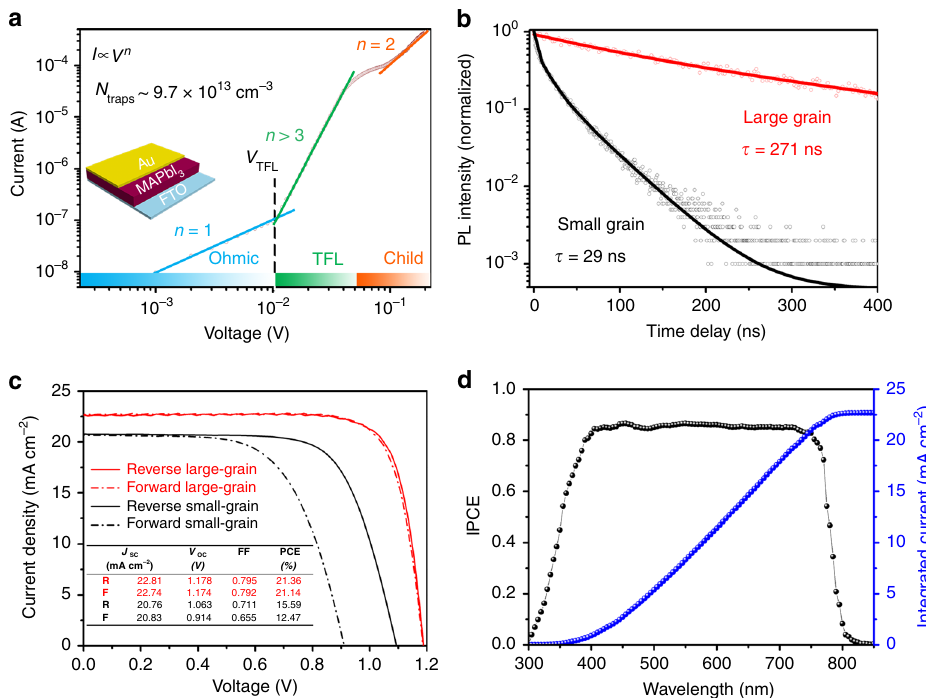
Fig. 4 Characterization of the large-grain MAPbI 3 perovskite fi lms. a Current – voltage ( I – V ) trace of the large-grain MAPbI 3 fi lm, showing Ohmic, TFL, and Child region. The onset voltage of the TFL region is ~0.011 V. b Time-resolved photoluminescence (TRPL) decay measurements of the large- and small- grain MAPbI 3 fi lms. c Characteristic I – V curves of the large- and small-grain devices. Solid lines and dashed lines indicate the reverse- and forward-bias scan directions, respectively. d The IPCE spectrum of the large-grain device and the integrated short-circuit current density ( J SC ) versus large-grain perovskite fi lm shows greatly improved stability in comparison with that of the small-grain device. The large-grain device retains over 80% of its initial PCE after 200 h, whereas the control device decays to <20% of the original performance. In addition, the XRD patterns of the large- and small-grain fi lms were recorded before and after exposure to humidity of 65% for 200 h at RT in air, and the results are shown in Supplementary Fig. 24. After the 200-h aging, a set of peaks of PbI 2 appeared with high intensity for the small-grain fi lm, showing poor stability. In contrast, the large-grain fi lm showed greater stability, showing very weak peaks from PbI 2 and the hydrate intermediate under the same aging condition. The enhanced humidity stability is likely to be attributed to the intrinsic properties such as uniaxially oriented grains and reduced grain boundaries, which can effectively inhibit the permeation of moisture in the large-grain perovskite fi lm 25 . As shown in Fig. 5d, the large-grain fi lm did not change markedly in color over 200 h, showing excellent stability, whereas the small-grain fi lm turned yellow under the same conditions, because of fast decomposition of MAPbI 3 with water, and forming PbI 2 in the small-grain fi lm. Likewise, the enhanced stability in the large-grain device can also be observed under thermal stressing and full-spectrum sunlight irradiation, as shown in Fig. 5b, c. The large-grain devices retain around 80 and 85% of their initial PCEs, respectively, under thermal stressing at 65 °C and under the illumination after 1000 h, whereas the control devices decay to about 30 and 60% of the original PCEs, respectively, under the identical conditions. The high stability under the illumination and the heat could be ascribed to effective suppression of ion migration in the large-grain perovskite fi lm with high crystallinity and reduced grain boundaries 26,27 . The signi fi cantly improved stability as well as high ef fi ciency indicate the great potential of the large-grain perovskite solar cell for industrial applications.